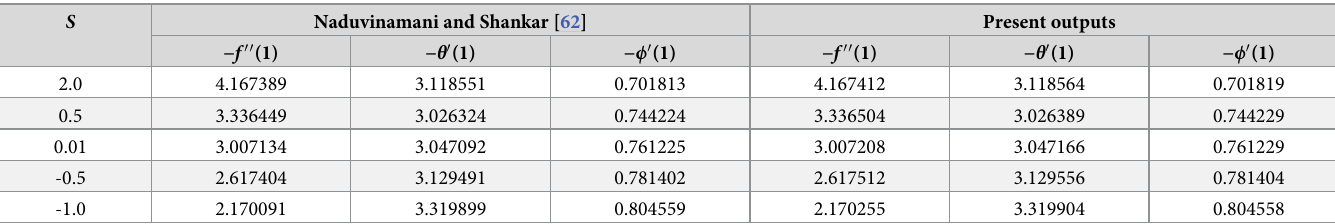
Table 2. Numerical outputs of − f 00 (1), − θ 0 (1) and ϕ 0 (1) for S as λ 1 !1 , Da !1 , γ = Ha = R d = N t = 0, δ = 0.1, De = N b = 10 − 10 and Ec = Pr = Le = R =